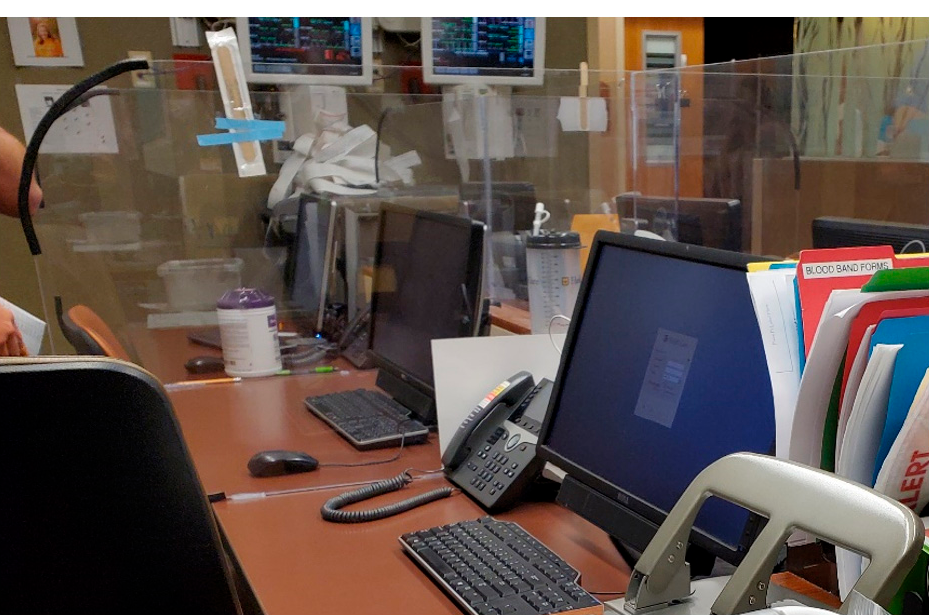
Figure 2. Dividers installed between workstations.